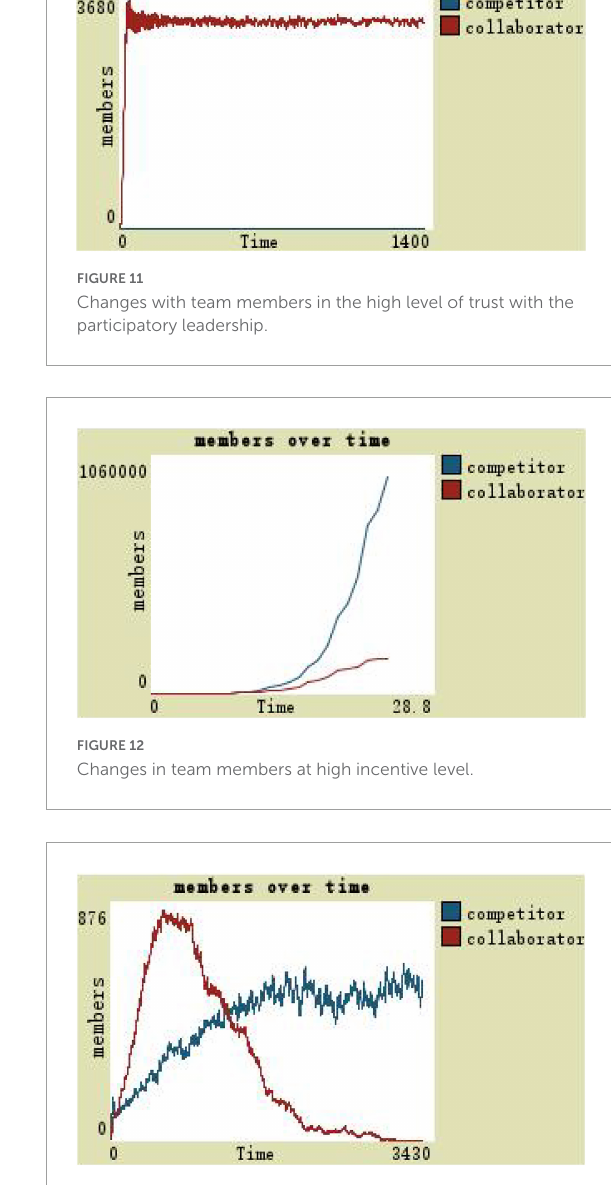
FIGURE13 Team members change with the low level of